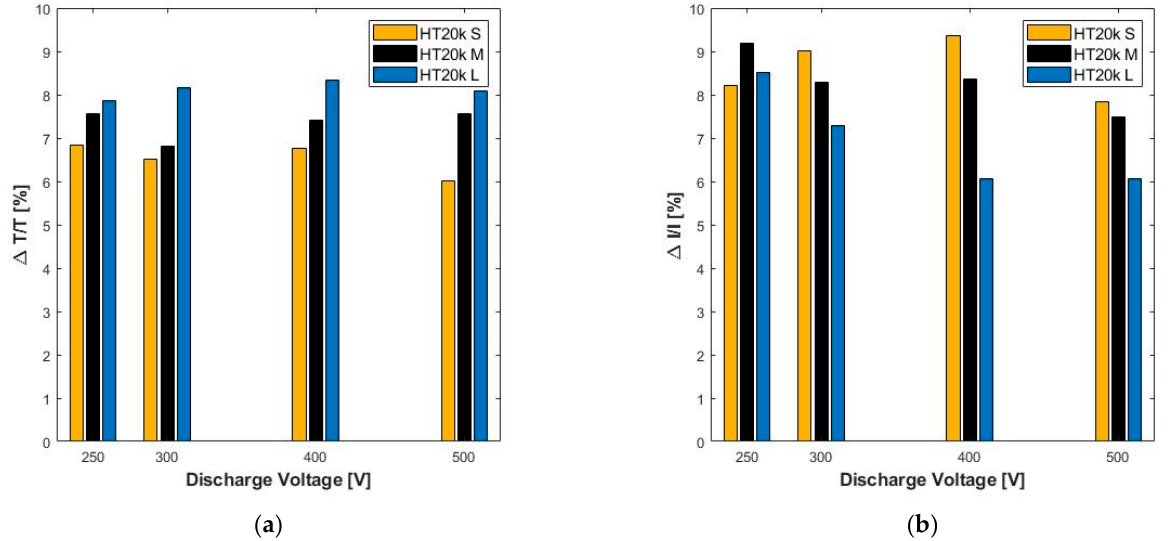
Figure 10. Average variations of thrust ( a ) and discharge current ( b ) for all the tested mass flow rates as a function of all the discharge voltage for all the tested points on the three thruster configurations. To sum up, the average changes stayed in the 6–8% range for the thrust and 6–9% for the discharge current.